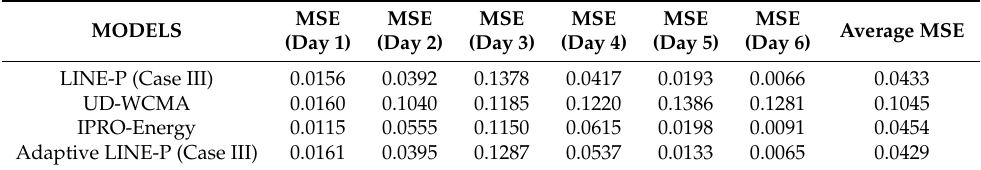
Table 11. Error comparison of the prediction models based on MSE for the SDG&E solar energy profile.